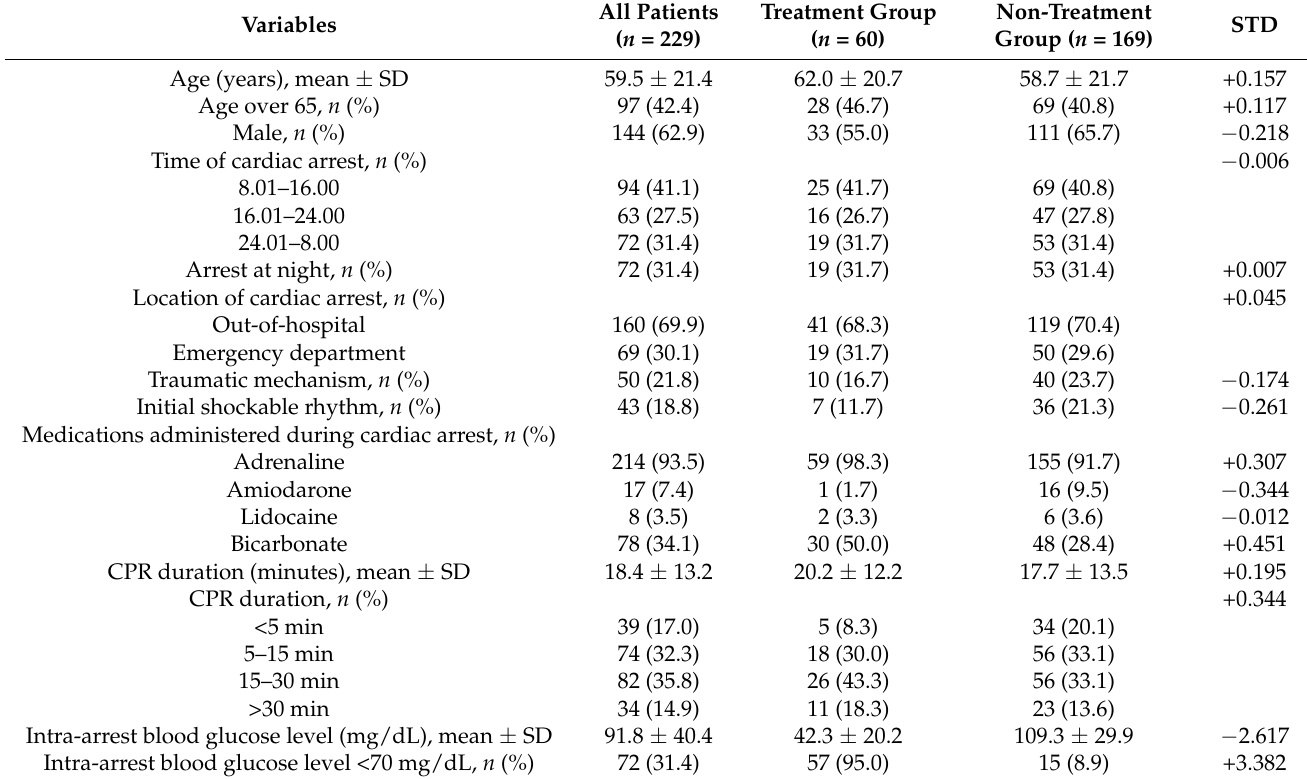
Table 1. Baseline characteristics, clinical features, and interventions of the study cohort.